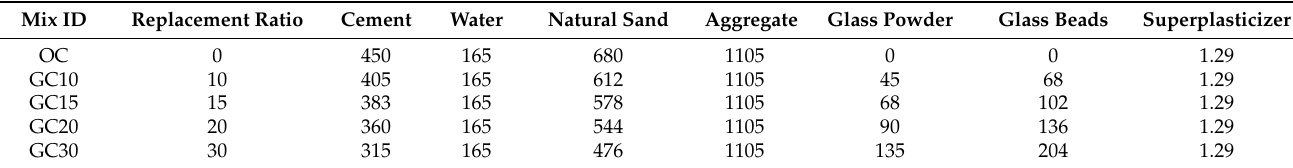
Table 1. Mix proportions of OC and GC (kg/m 3 ).